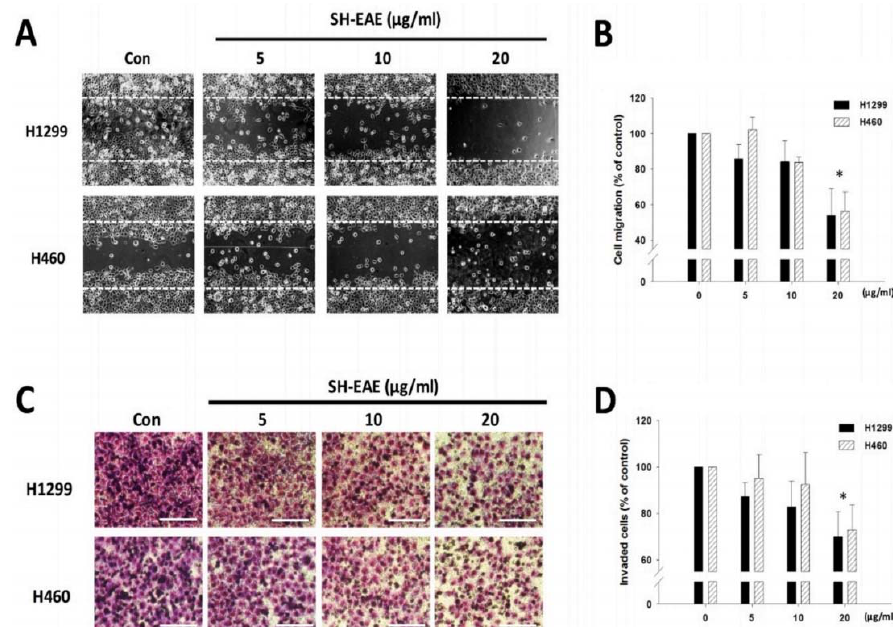
Figure 5. SH ‐ EAE decreased H1299 and H460 cell migration and invasion in vitro. ( A ) Representative 4× magnification images at 16 h. H1299 and H460 cells in confluence were scratched and then treated with different concentration (5, 10, and 20 μ g/mL) of SH ‐ EAE for 16 h. The cells were fixed in 4% paraformaldehyde solution. The area between the two dotted lines indicates the wound width of SH ‐ EAE (20 μ g/mL) ‐ treated cells at 16 h after scratching. ( B ) The quantifications of the regions of the cell during migration were analyzed using a software “TScratch”. Data represent the mean ± SD of three independent experiments. (* p < 0.05). ( C ) Cell invasion was determined using ThinCert™ cell culture transwell inserts, showing representative images of the bottom surface of the transwell membrane in H1299 and H460 cells. Scale bar indicates 1000 μ m. ( D ) The number of invaded cells in four random microscopic fields (×200) was counted for each group. Data are shown as means ± SD of three independent experiments. (* p < 0.05).